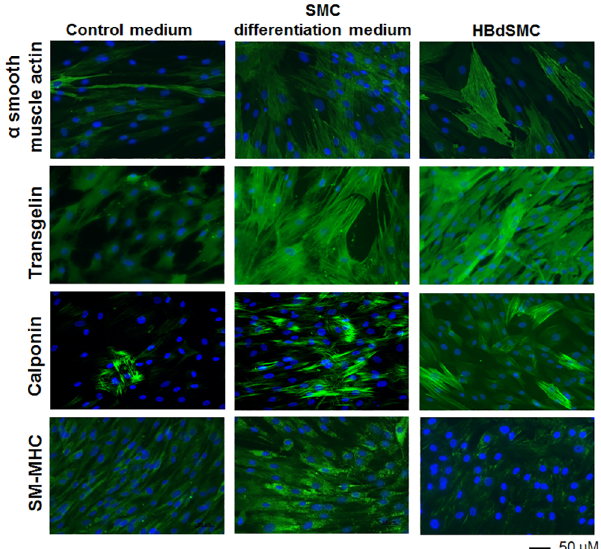
Fig 2. Expression of contractile SMC-specific proteins analyzed by immunofluorescence. MSCs were expanded in GMP expansion medium until they were 70% confluent and at passage 2 treated with control medium or SMC differentiation medium for 14 days, fixed and then analyzed by immunofluorescence for expression of α SMA, transgelin, calponin and SM-MHC. Primary human bladder smooth muscle cells (HBdSMC) served as the positive control. Nuclei were stained with DAPI. Magnification 20x. Representative of n = 3.